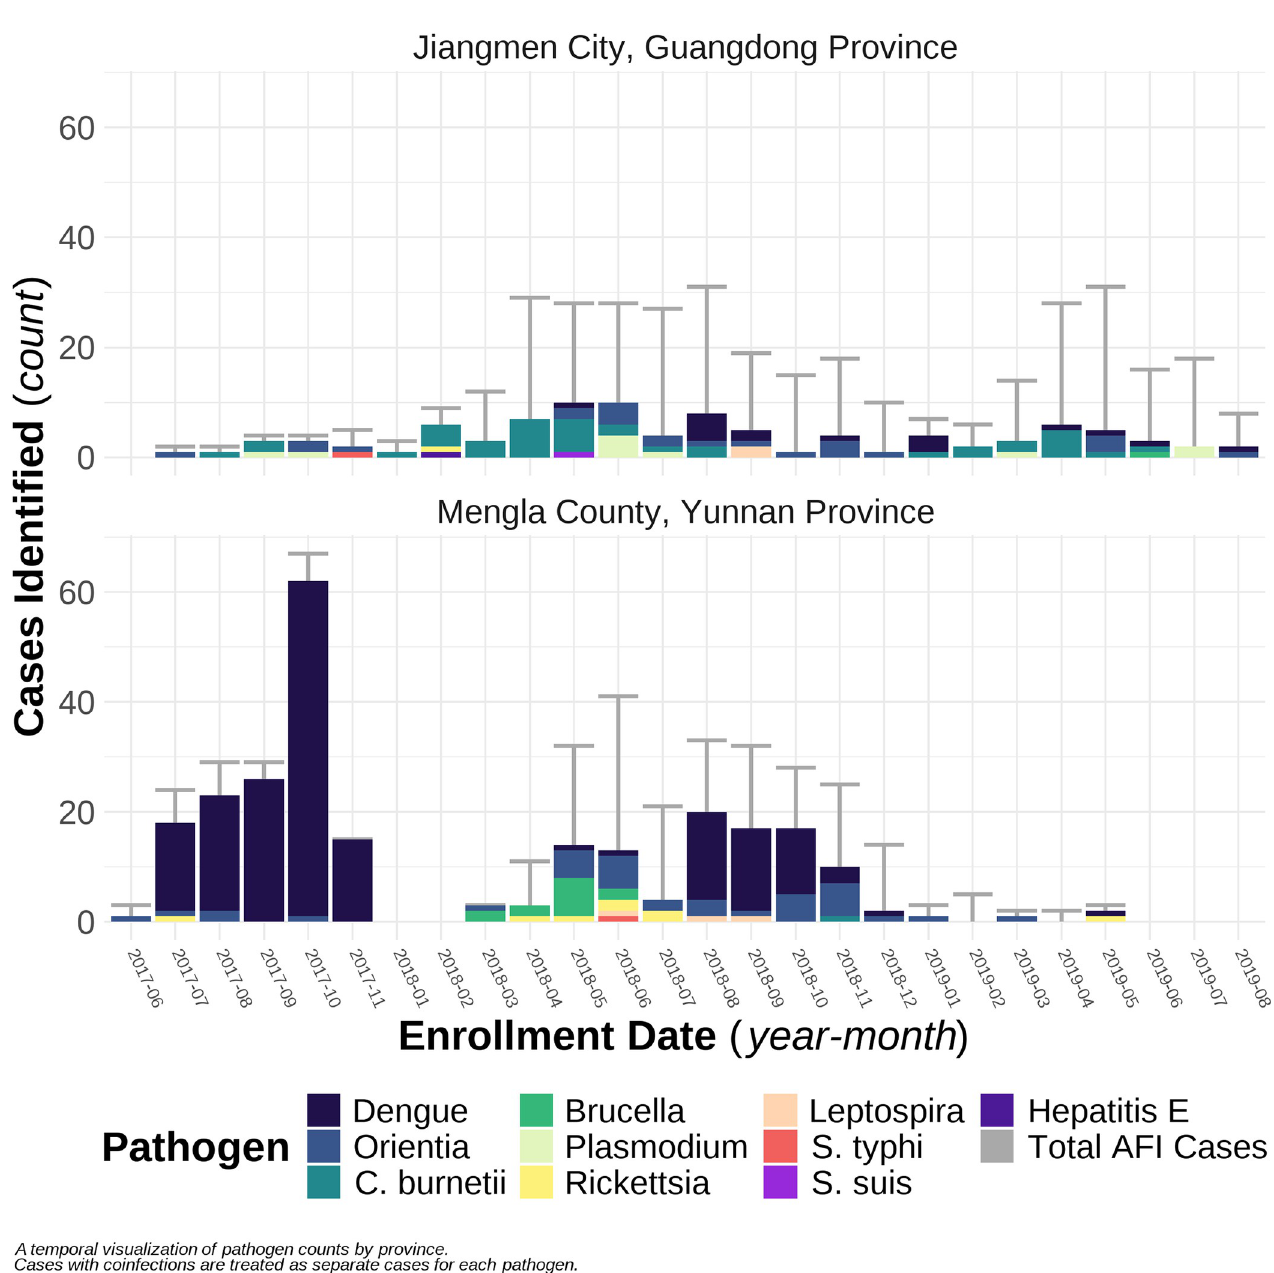
Fig 2. Temporal distribution of patients enrolled in the acute febrile illness surveillance project by TaqMan Array Card (TAC) diagnostic test results and location, China, June 2017–July 2019.